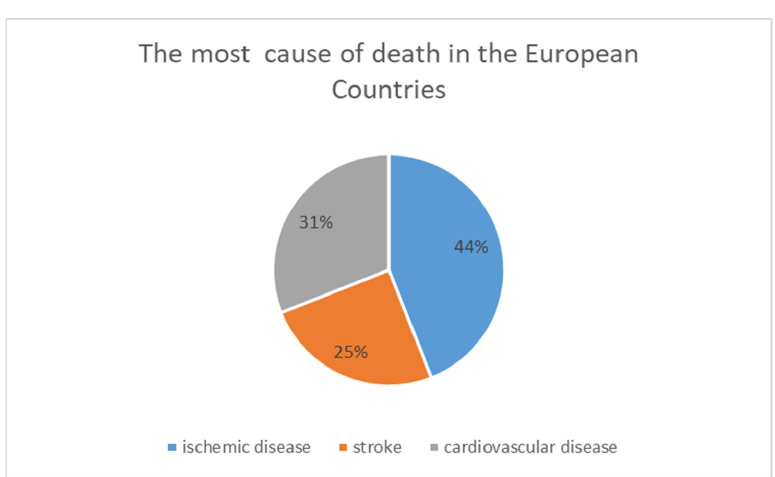
Figure 1. Distribution of death for cardiovascular, ischemic, stroke, diseases.